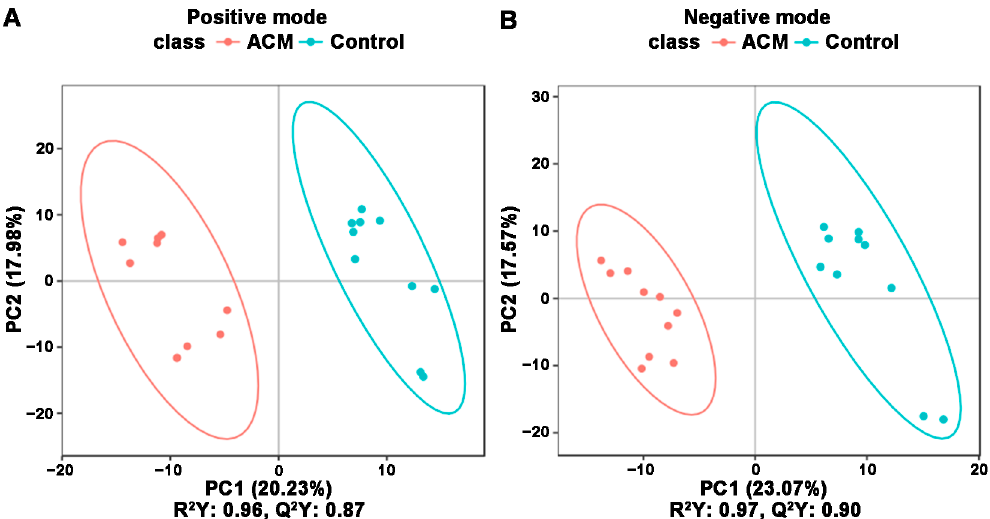
Molecules 2021 , 26 , x FOR PEER REVIEW Figure 4. PLS-DA between the control and ACM groups. ( A ) Positive mode; ( B ) negative mode. Score plot from PLS-DA of the two compared groups. Each datapoint represents a function of the entire spectral profile of each subject.